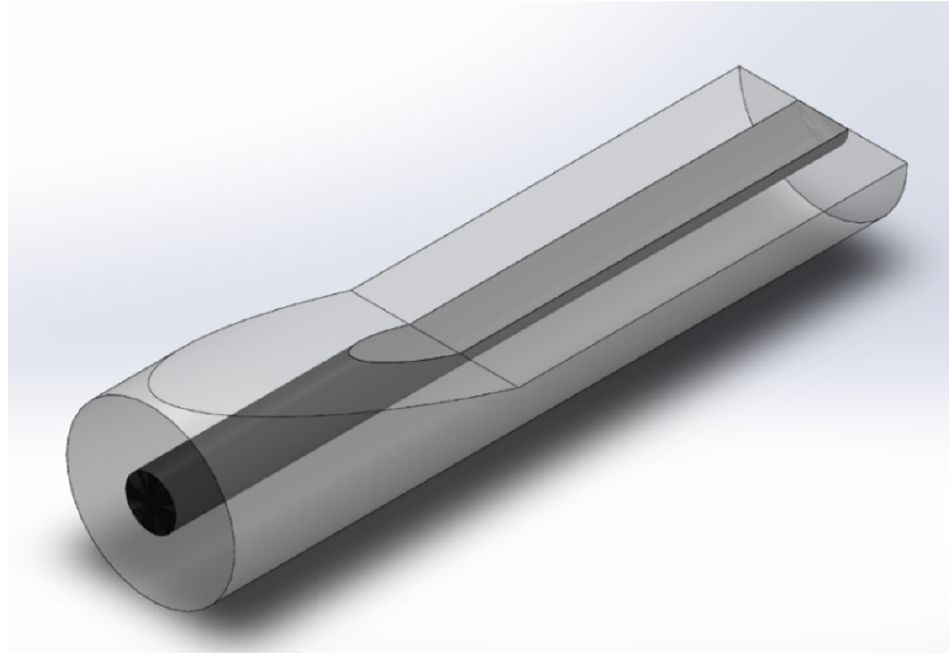
Figure 2. Model of our proposed DSCF.